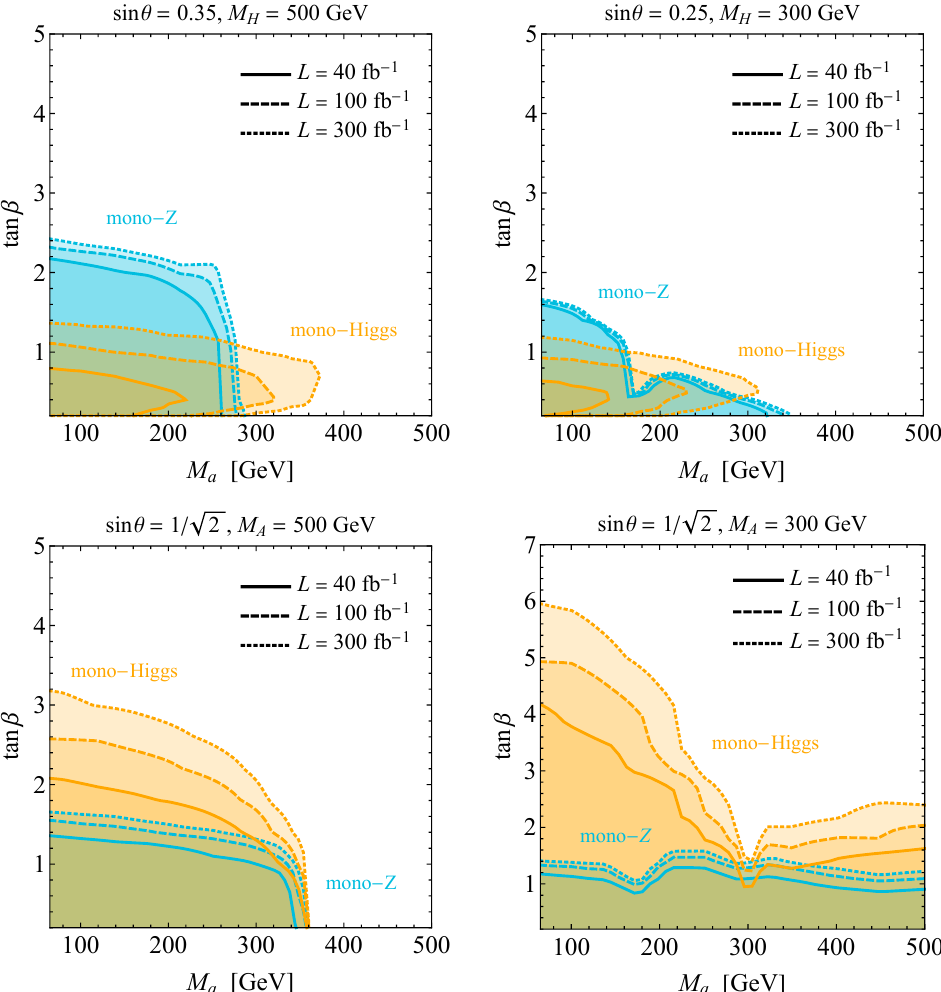
Figure 14 . 95% CL exclusion contours for our four benchmark scenarios following from hypothet- ical Z + E T; miss (blue regions) and h + E T; miss (orange regions) searches at 13 TeV LHC energies. The solid, dashed and dotted curves correspond to integrated luminosities of 40 fb (cid:0) 1 , 100 fb (cid:0) 1 and 300 fb (cid:0) 1 ,